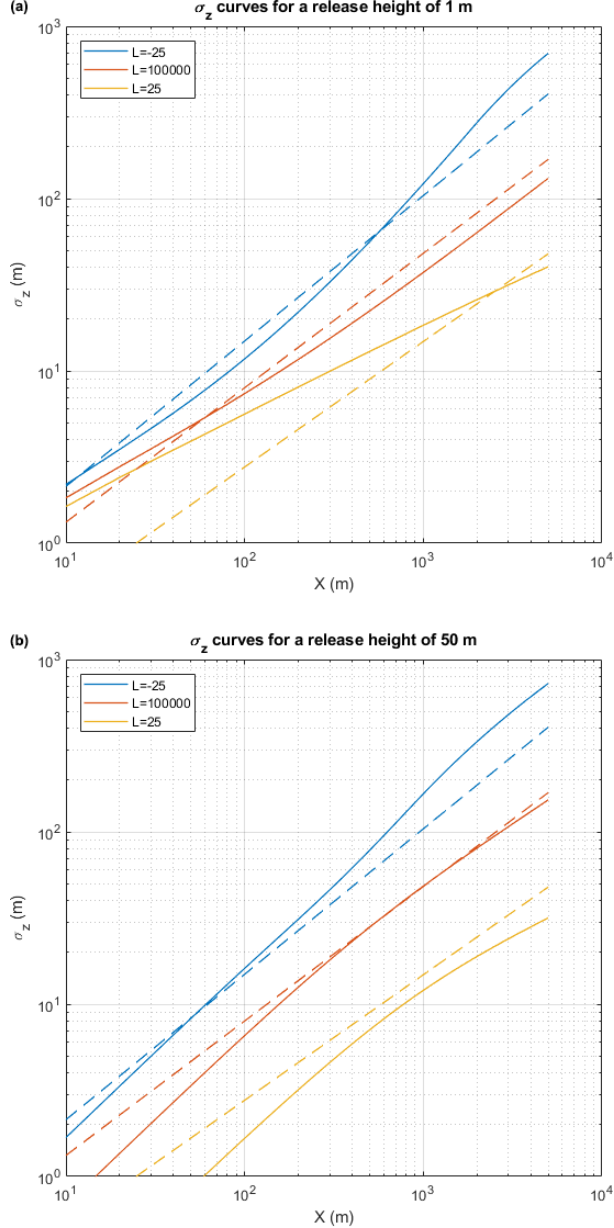
Figure 3. Comparison of derived σ z curves discussed in the text with standard ASME curves (Smith, 1973) using Eq. (24). To the left is a 1m release and to the right a 50m release. Three differ- ent stability classes, specified by the Monin–Obukhov lengths ( L ), are shown. The K z method is shown as a solid line and the ASME curves as dashed lines. The ASME curves have no release height or surface roughness dependence but are included as reference. Values of z 0 = 0 . 5m, relevant for urban areas, and σ z 0 = 0 are